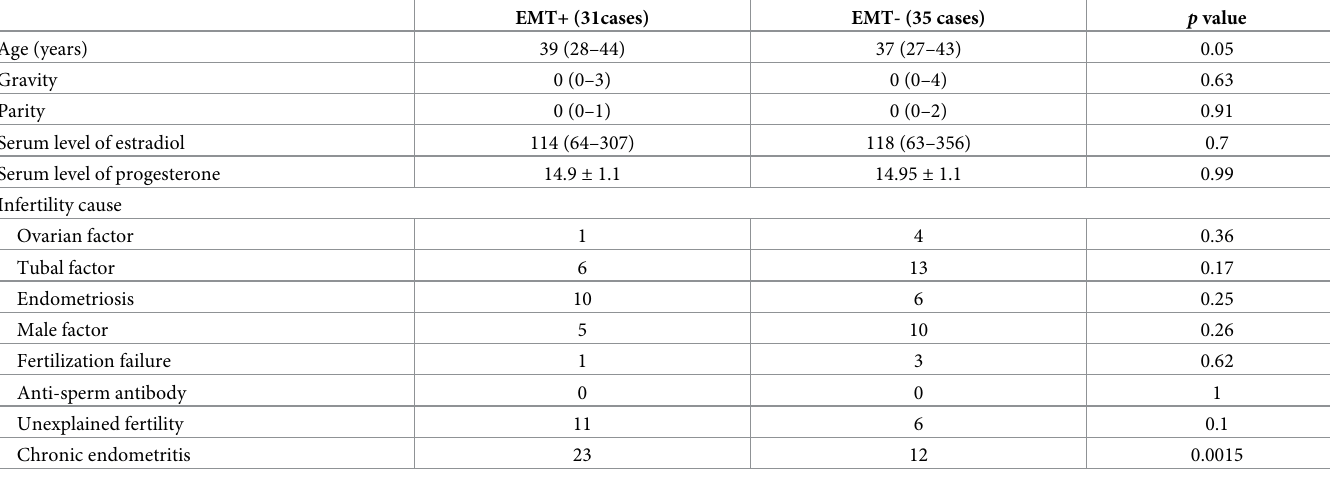
Table 4. Patient characteristics in the EMT-positive and EMT-negative